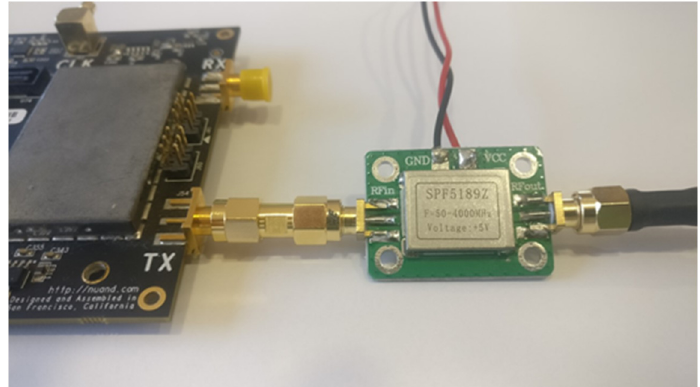
Figure 10. Power amplifier SPF5189Z.